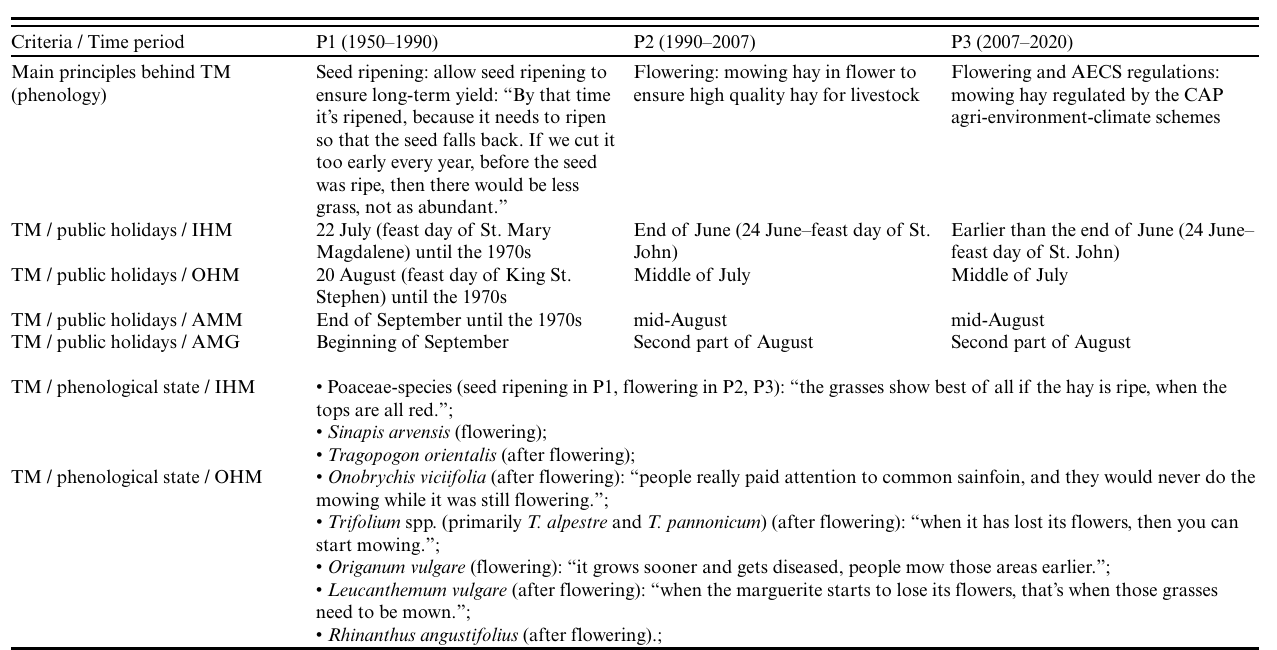
Table 1 . The most important culturally and agriculturally defined indicators of the time of mowing in Gyimes in the three studied time periods (abbreviations: TM: time of mowing, IHM: inner hay meadow, OHM: outer hay meadow, AMM: aftermath mowing, AMG: aftermath grazing, AECS: agri-environment-climate